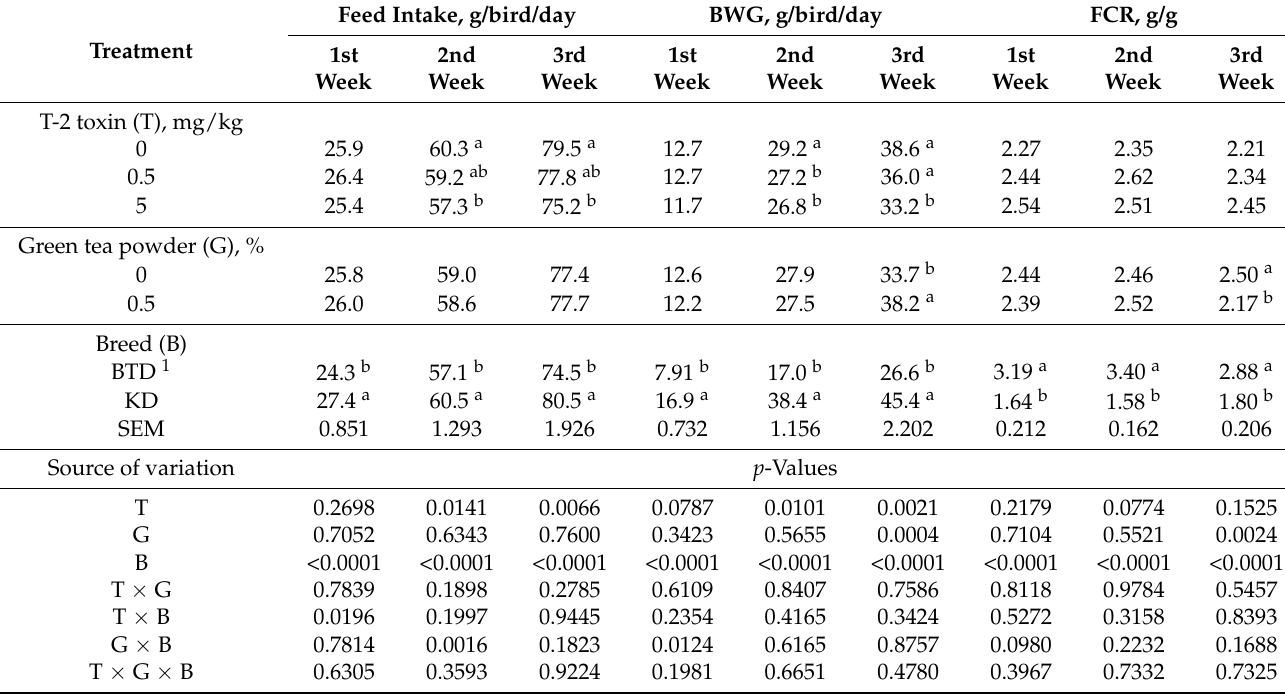
Table 3. Effects of diets containing T-2 toxin and green tea powder on growth performance of Brown Tsaiya ducklings and Kaiya